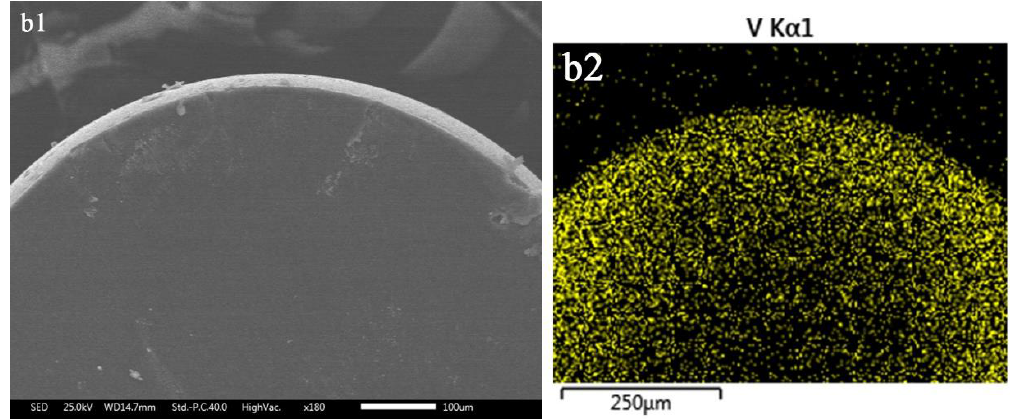
Figure 5. Scanning electron microscopy-energy dispersive spectrometer (SEM-EDS) plane scan analyses of the cross section of NIRs ( a1 ): the morphologies; ( a2 ): the distribution of V(V) and N-TIRs ( b1 ): the morphologies; ( b2 ): the distribution of V(V) after adsorption of V(V).